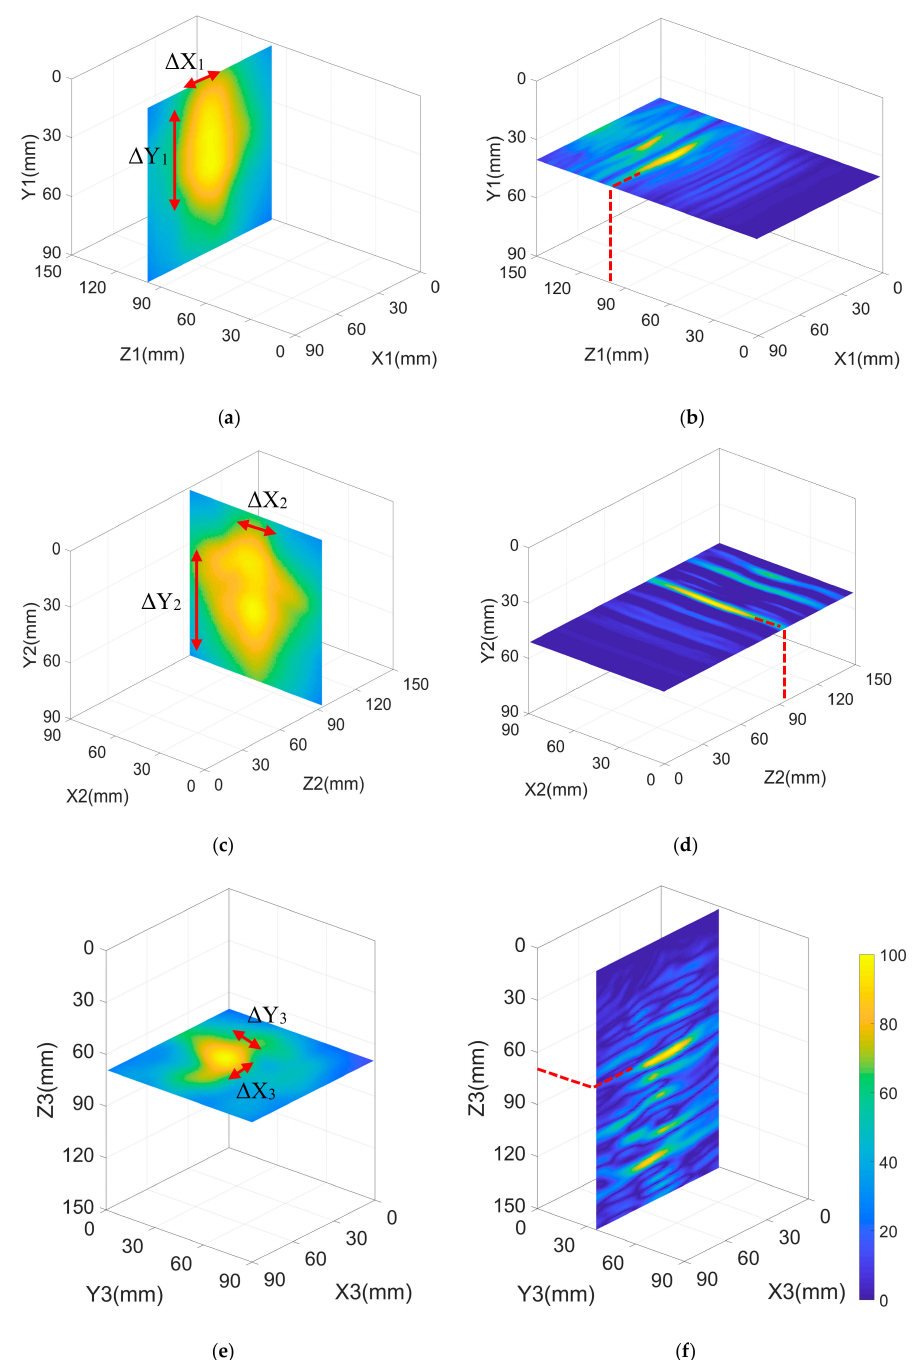
Figure 3. The SAFT algorithm results of the three-face experiment: ( a ) X 1 Y 1 plane slice for face 1 at Z 1 = 99 mm; ( b ) X 1 Z 1 plane slice for face 1 at Y 1 = 40 mm; ( c ) X 2 Y 2 plane slice for face 2 at Z 2 = 95 mm; ( d ) X 2 Z 2 plane slice for face 2 at Y 2 = 51 mm; and ( e ) X 3 Y 3 plane slice for face 3 at Z 3 = 70 mm f) X 3 Z 3 plane slice for face 3 at Y 3 = 36 mm. (color map at bottom right applies to all